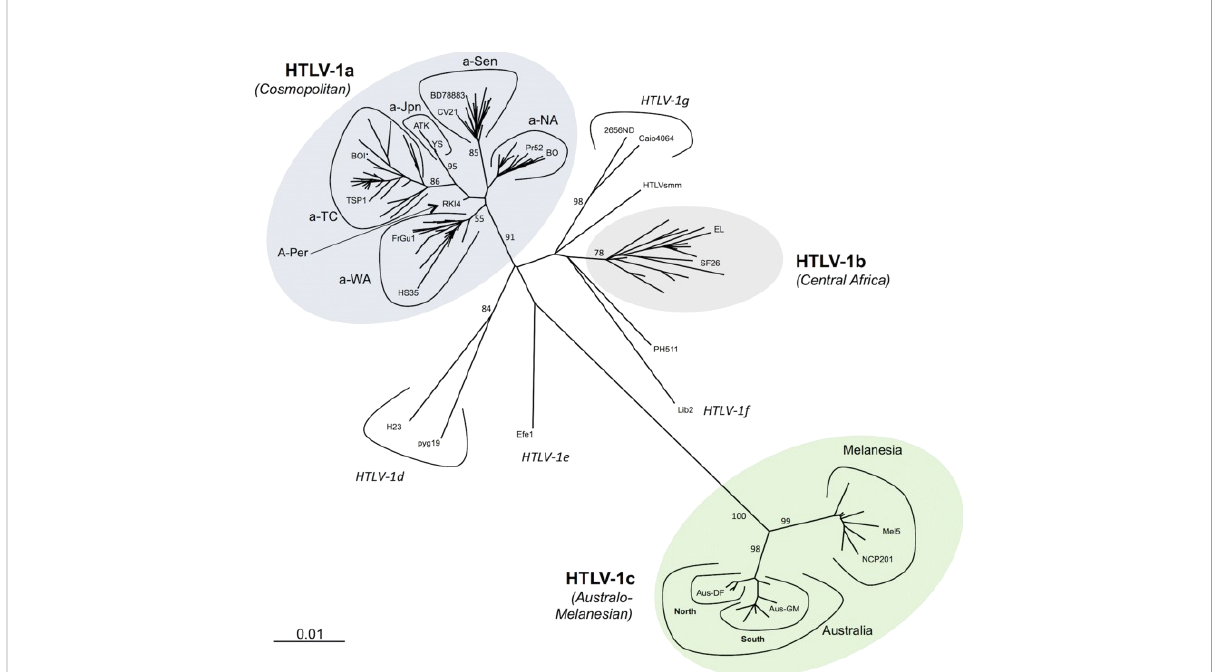
FIGURE 1 Phylogenetic representation of the HTLV-1 genotypes and subgroups. An alignment of complete LTR sequences (774 nucleotides long) from 178 HTLV-1 strains was obtained. The unrooted phylogenetic tree was generated with the neighbor-joining method using the GTR model (gamma=0.50). Branch lengths are drawn to scale, with the bar indicating 0.01 nucleotide replacements per site. Numbers on each node indicate the percentage of bootstrap samples (of 1000 replicates). HTLV-1 genotypes (a-g) and subgroups with HTLV-1a and HTLV-1c are presented. Published with permission from the author and journal